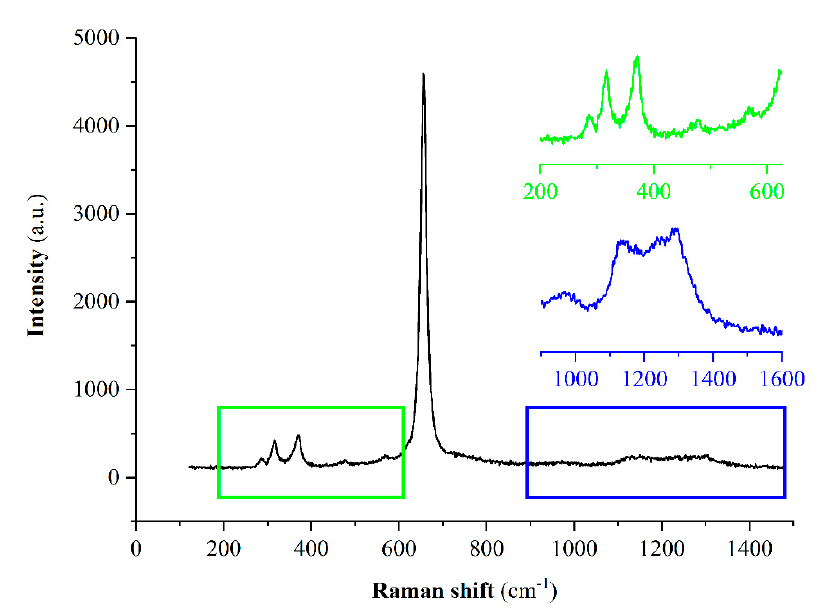
Figure 4. Raman spectra for the Mn-biosorbent after boron sorption.